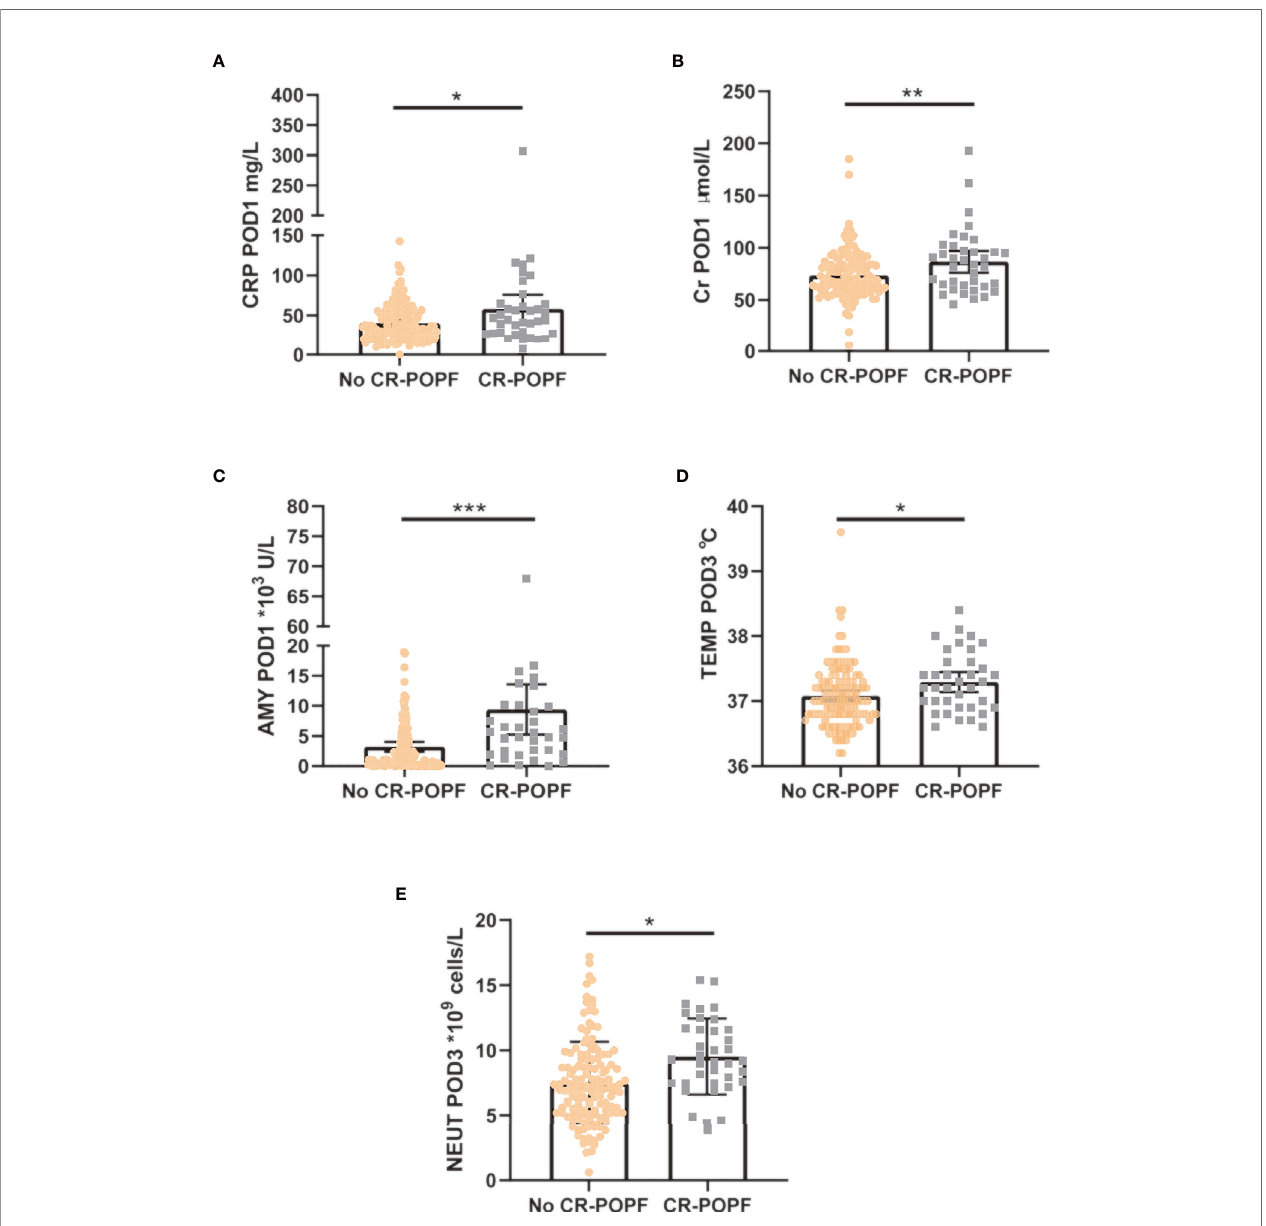
FIGURE 1 | Quanti fi cation of CRP at POD1 (A) , Cr at POD1 (B) , AMY at POD1 (C) , TEMP at POD3 (D) , and NEUT at POD3 (E) distinguishing patients with CR- POPF from those without CR-POPF. The error bars represent median ± standard deviation. CRP at POD1, C-reactive protein at postoperative day 1; Cr at POD1, Creatinine at postoperative day 1; AMY at POD1, amylase of drainage at postoperative day 1; TEMP at POD3, temperature at postoperative day 3; NEUT at POD3, neutrophils at postoperative day 3; CR-POPF, clinically relevant postoperative pancreatic fi stula. *P < 0.05, **P < 0.01, ***P <